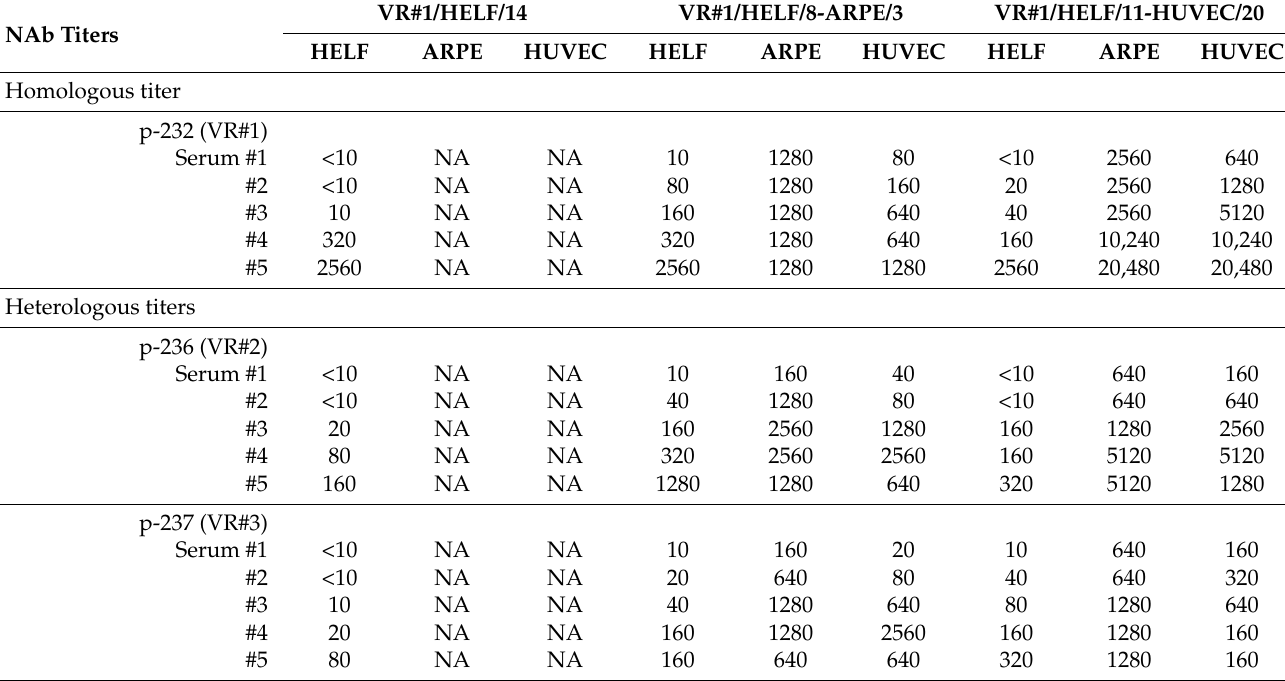
Table 1. Homologous and heterologous NAb titers of p-232 vs. VR#1 (homologous) and p-236 and p-237 vs. VR#1